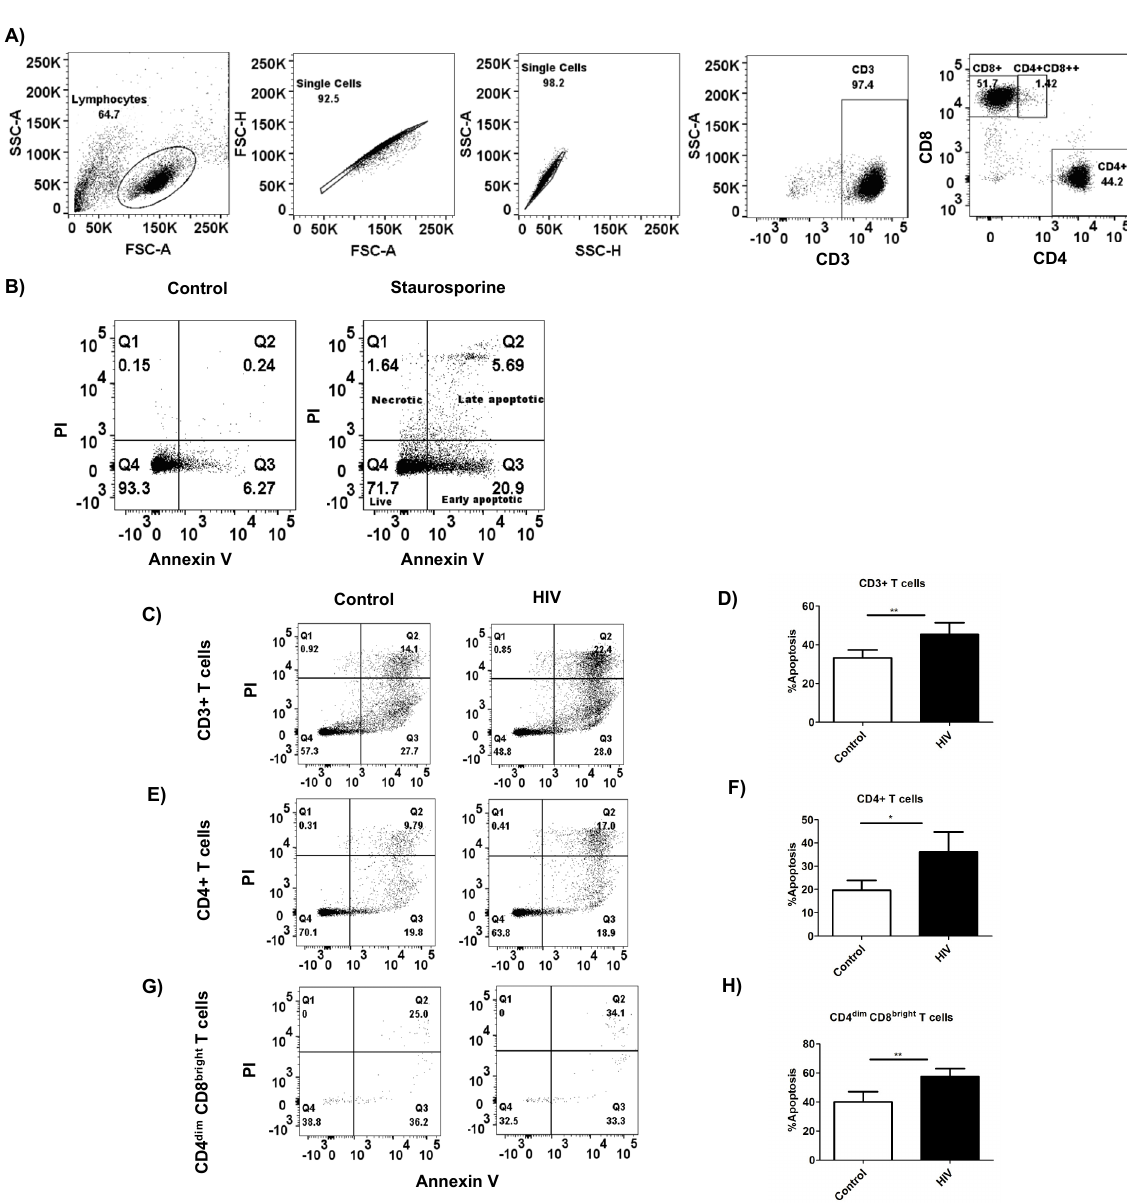
Figure 1. HIV infection induces apoptosis-mediated cell death in CD3+, CD4+, and CD4 dim CD8 bright T cells. ( A , B ) PBMCs were cultured in complete RPMI and activated for 3 days in the presence of 30 U/mL IL-2 and then treated with staurosporine (1 µ M) for 24 h. ( A ) Gating strategy for lymphocytes was based on side scatter (SSC-A) versus forward scatter (FSC-A). Doublets were excluded by gating for FSC-A vs. FSC-H then SSC-A vs. SSC-H. T cells were gated on the basis of the surface expression of CD3 and further broken down into CD8 single positive (CD8 bright CD4 − ), CD8 double positive (CD4 dim CD8 bright ), or CD4 single positive (CD4 bright CD8 − ), as shown. ( B ) General gating strategy to measure apoptosis and/or necrosis by an annexin/PI flow-based assay in each cell population, as shown in representative dot plots. Left to right, control, staurosporine (1 µ M). ( C – H ) Three-day-activated PBMCs were infected with HIV Bal for 6 h or left uninfected, washed, and cultured in complete RPMI for 6 days. ( C , E , G ) Representative dot blots of day six post infection or control (non-infected) cells showing annexin V positive populations in CD3+, CD4+ and CD4 dim CD8 bright T cells, respectively. ( D , F , H ) Cumulative data of percent apoptosis (early and late apoptosis) on day six post infection and control in CD3, CD4+ and CD4 dim CD8 bright T cells populations. n = 4 per treatment. Data are represented as mean ± SEM and analyzed using one-way ANOVA and Newman–Keuls multiple comparisons test. * means p ≤ 0.05, ** p ≤ Induction of Wnt/ β -catenin signaling protects T cell subsets from HIV-mediated apoptosis: To determine the impact of β -catenin on protecting T cell subsets from HIV- mediated apoptosis, we treated PBMCs with a 6-bromoindirubin-3-oxime (BIO), a small- molecule inducer of β -catenin which inhibits GSK-3 β , a component of the β -catenin de- struction complex. By inhibiting GSK3 β , β -catenin is hypophosphorylated and not tagged for proteasomal degradation. As expected, transfecting PBMCs with Topflash and treat- ing with BIO for 48 h significantly induced the luciferase reporter activity by 3–5-fold when compared with vehicle (DMSO) treatment (Figure S3A). PBMCs infected with HIV and treated with BIO demonstrated a significant reduction in total apoptosis by >40–50% in CD3+, CD4+, and CD4 dim CD8 bright T cells (Figure 2A–F). Interestingly, when divided into early and late apoptotic stages, both stages were found to be significantly rescued as a result of β -catenin induction in the absence or presence of HIV infection in CD3+ and CD4+ T cell populations (Figure S3B,C,E,F). However, in the CD4 dim CD8 bright T cell popu- lation, although not significant, there was a trend of rescue in the early stage (Figure S3D) which was not evident in the late stage (Figure S3G). Cumulatively, these data demon- strate that the induction of β -catenin signaling significantly protects CD4+ T lymphocytes from HIV-mediated apoptosis.